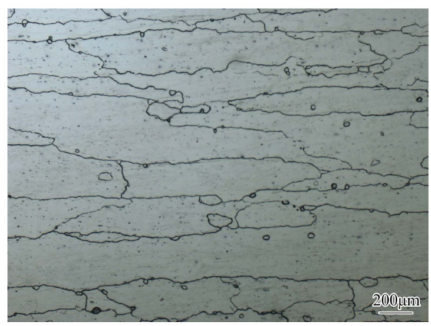
Figure 1. The original microstructure of the die-casting AZ31 Mg